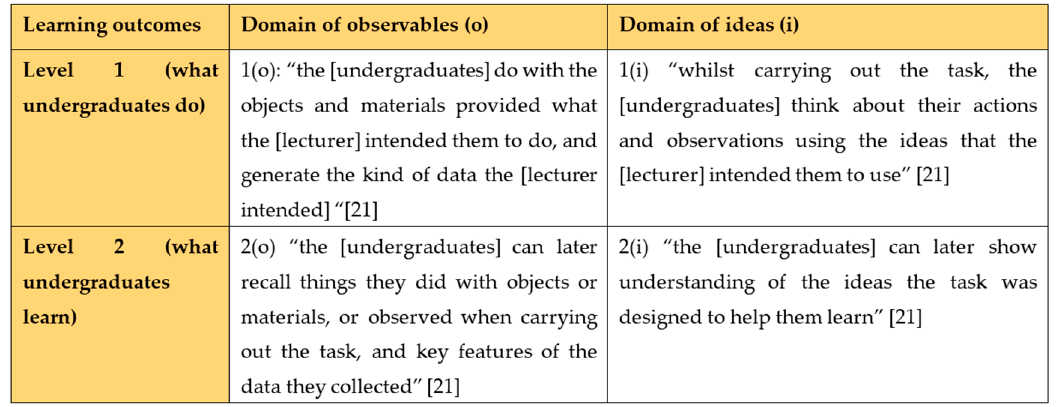
Figure 1. Theoretical model for the effectiveness of practical work. Adaptation from Millar et al. (1999) and Tiberghien [20,22].